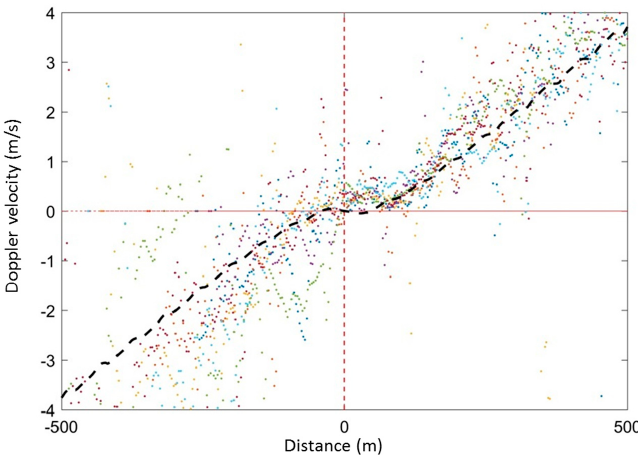
are used to distinguish between the different satellite passages.